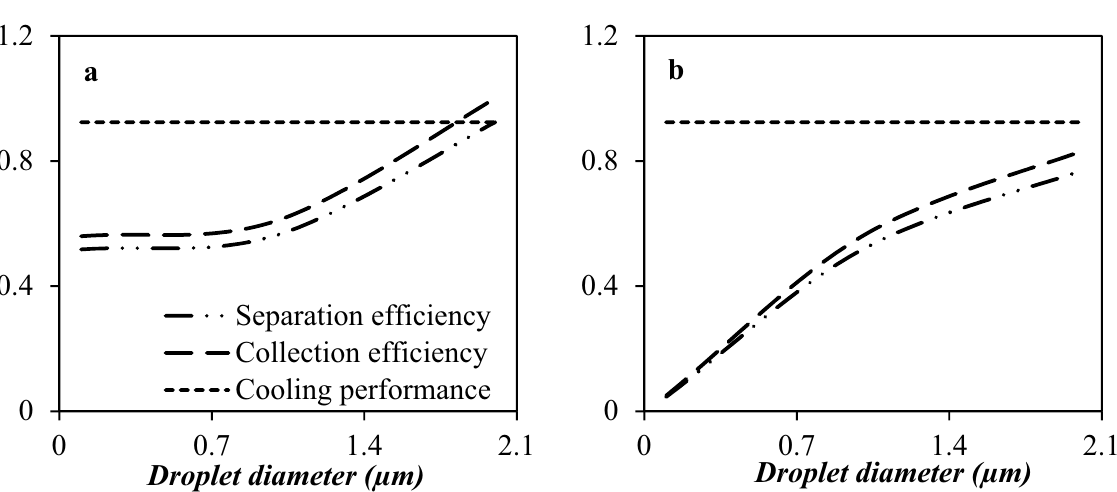
Figure 19. The influence of droplet size and density on the collection efficiency, cooling performance and separation efficiency of 3S for ( a ) water droplets and ( b ) HC droplets—(PRR =